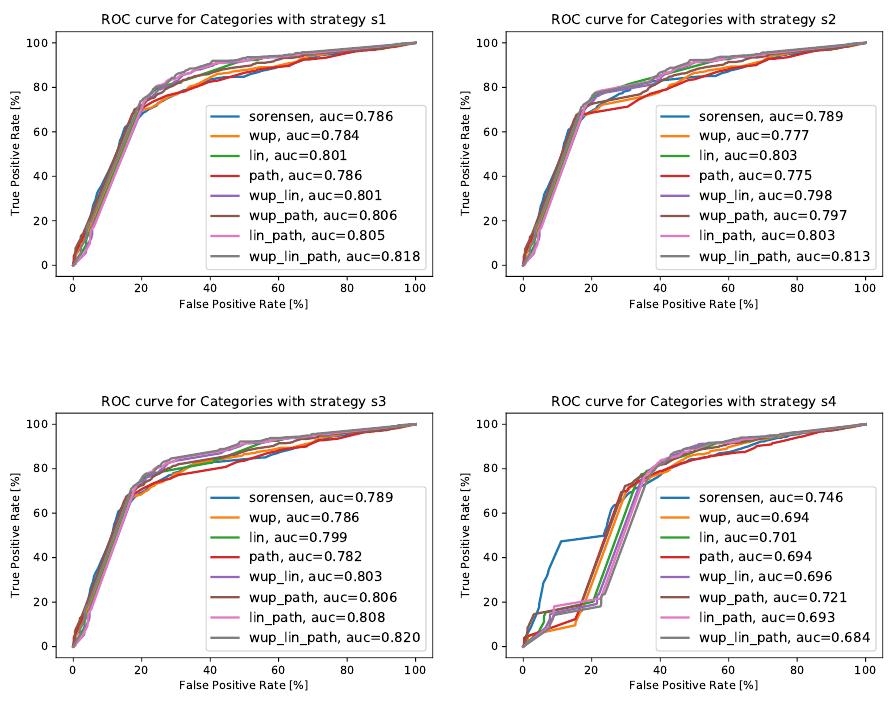
ROC curve for Categories with strategy s1 ROC curve for Categories with strategy s2